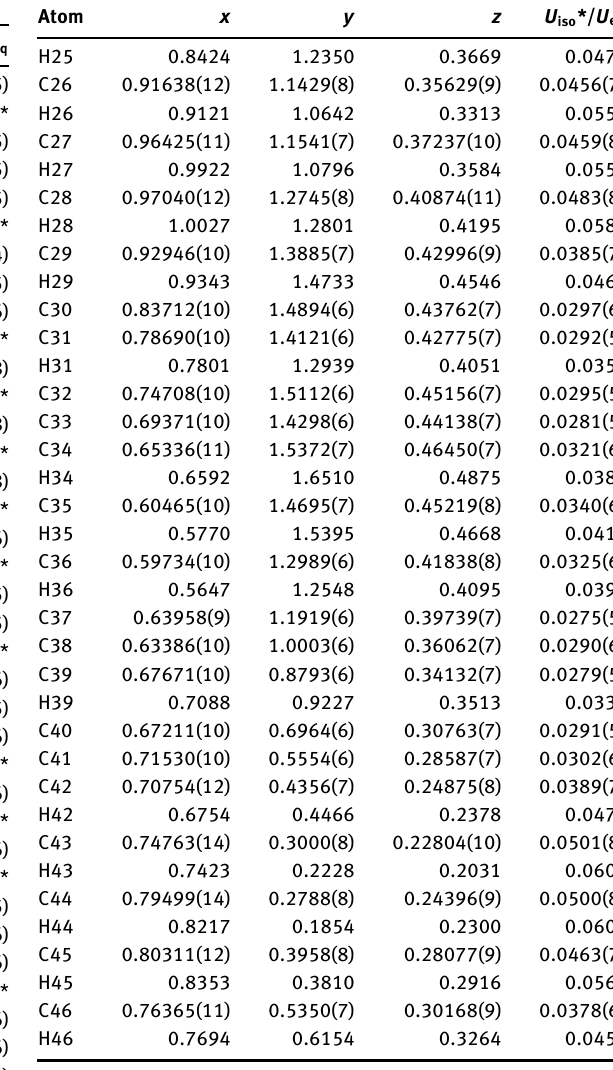
Table 2: Fractional atomic coordinates and isotropic or equivalent isotropic displacement parameters (Å 2